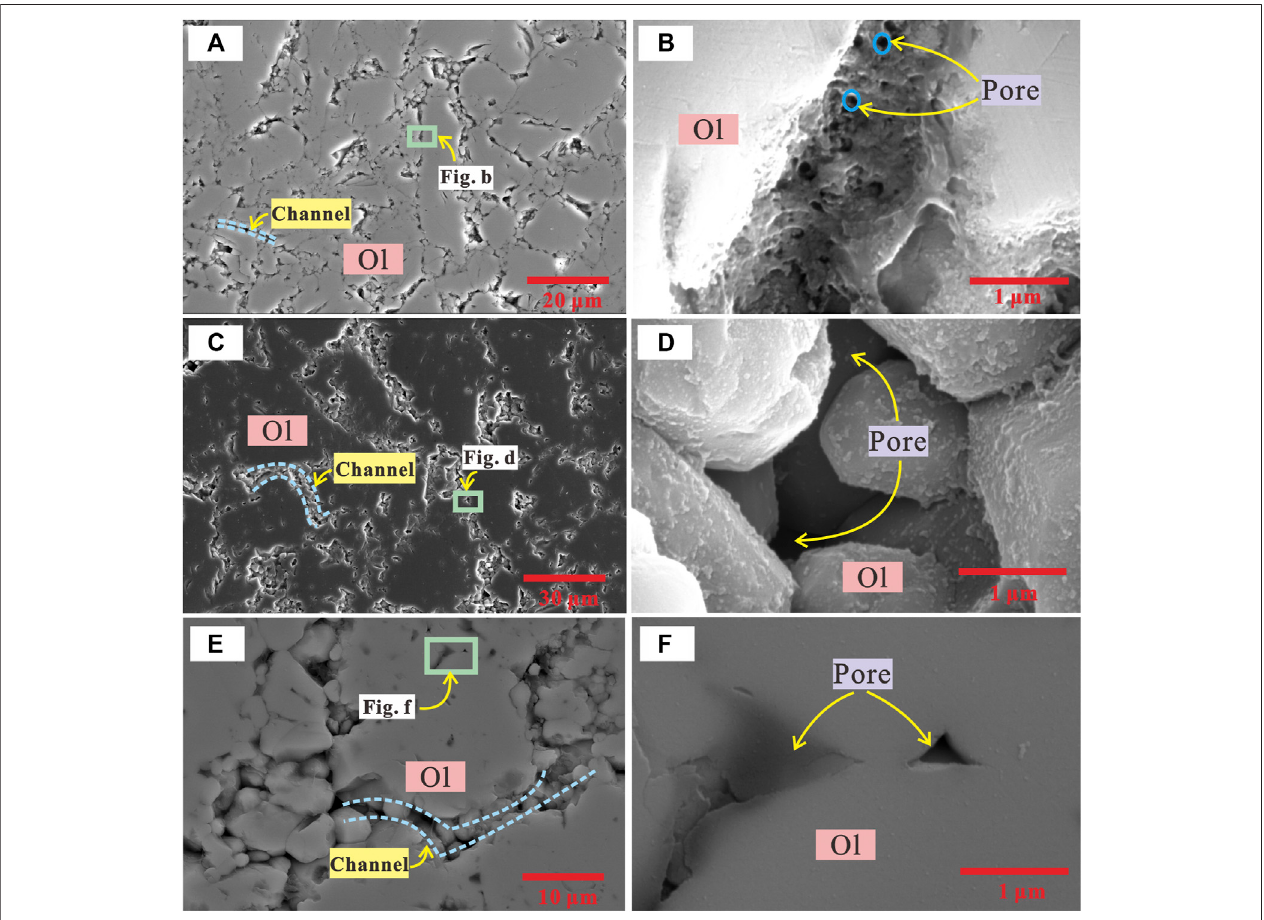
FIGURE 1 | Scanning electron microscope images of the recovered samples of saline fl uid-bearing olivine aggregates after electrical conductivity measurements. (A) and (B) show the Ol – NaCl – H 2 O system with a salinity of 5 wt% and fl uid fraction of 13.7 vol%, (C) and (D) show the Ol – CaCl 2 – H 2 O system with a salinity of 5 wt% and fl uid fraction of 10.7 vol%, and (E) and (F) show the Ol – NaCl – H 2 O system with a salinity of 5 wt% and fl uid fraction of 18.0 vol%. The saline fl uids are uniformly distributed on the olivine grain boundaries, and the cross-sections of pores occupied by saline fl uids contain triangular, elliptical, and irregular shapes. Fluid channels formed in the shattered zones among the large olivine